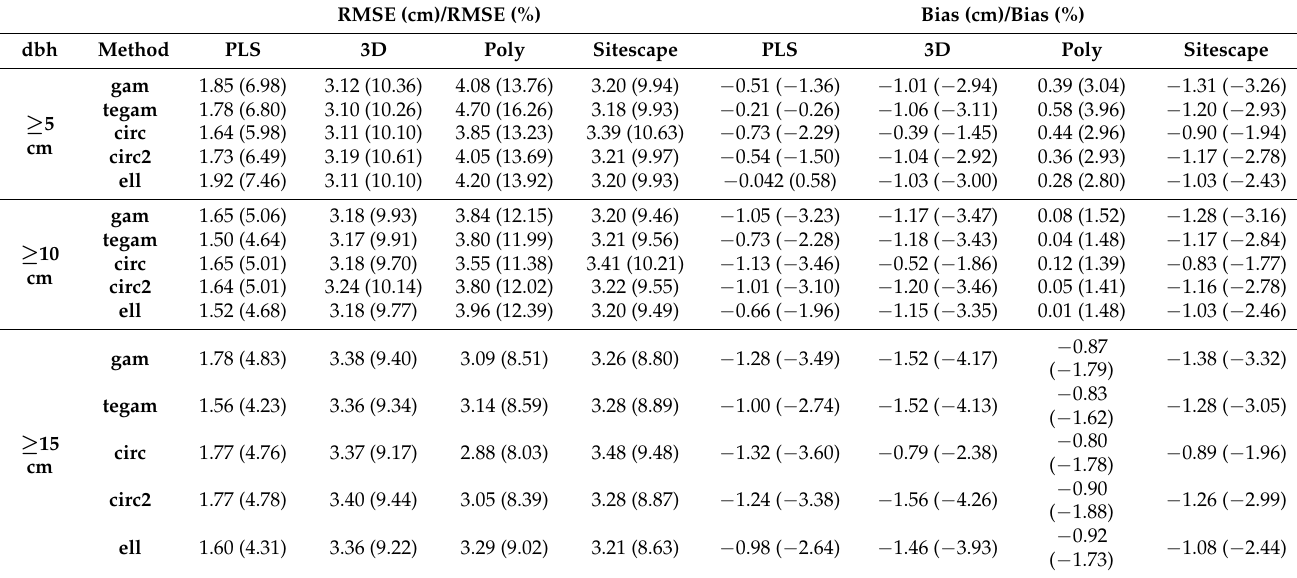
Table A4. RMSE and bias of dbh estimation for PLS/iPad and lower dbh